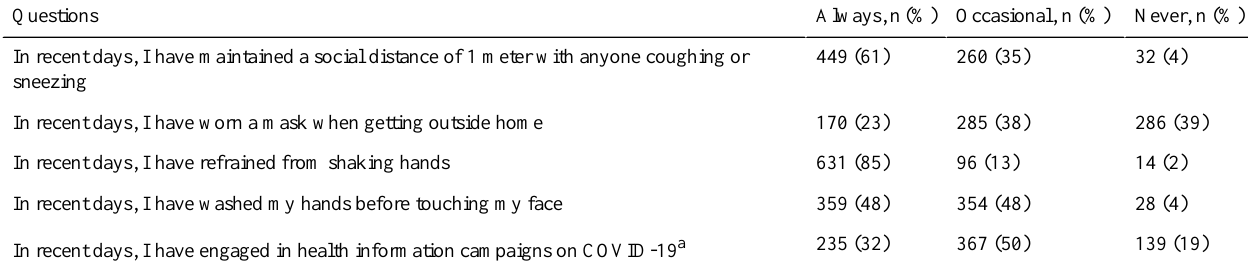
Table 6. Responses of Ugandan medical students (N=741) to questions on practices toward COVID-19.